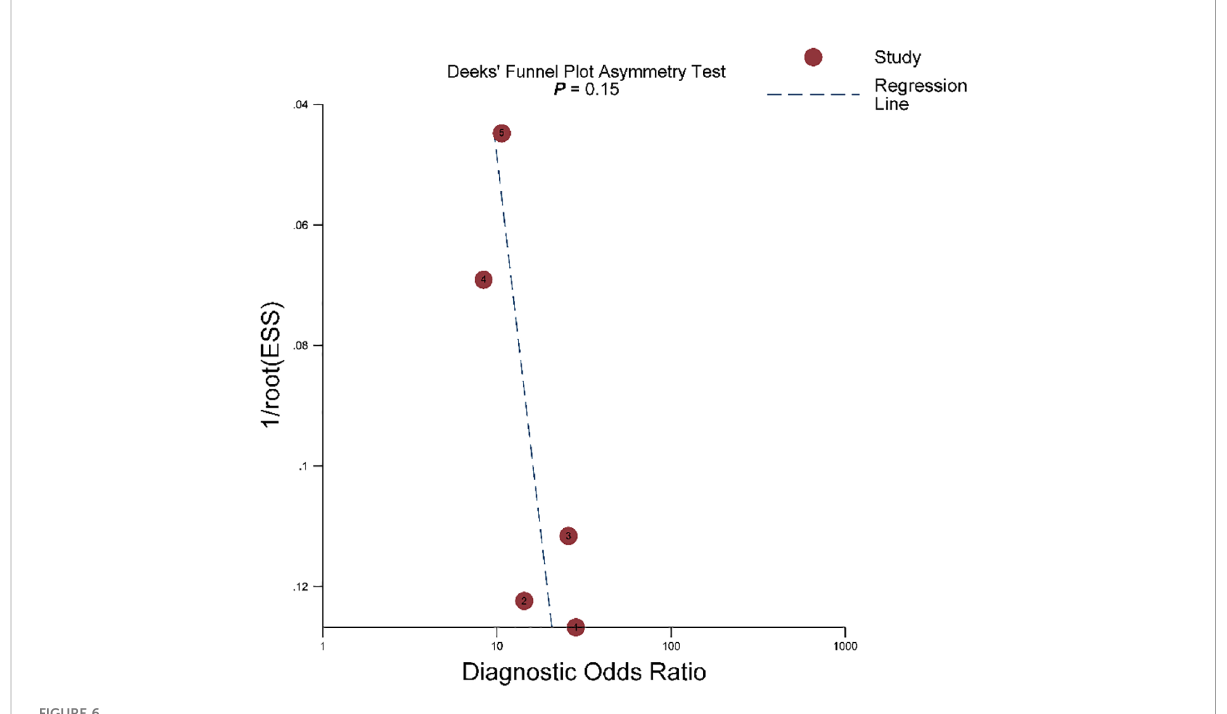
FIGURE 6 The Deeks ’ funnel